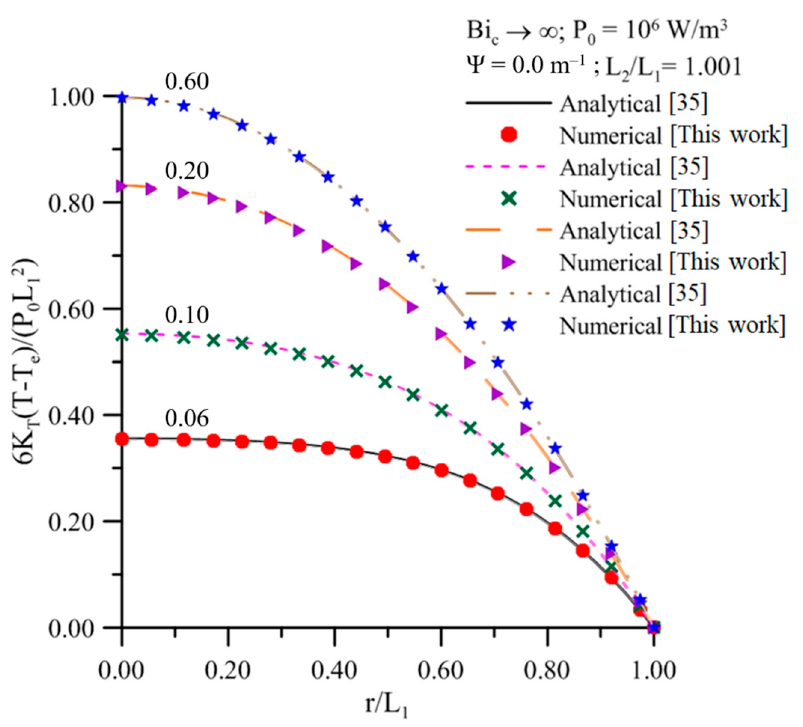
Figure 5. Dimensionless temperature behavior in a sphere with zero surface temperature and constant heat production for different heat transfer Fourier numbers.